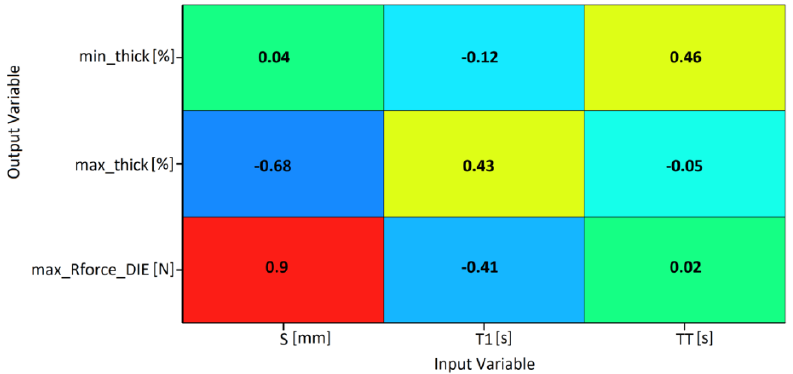
Figure 26. Linear correlation matrix, blank 0.